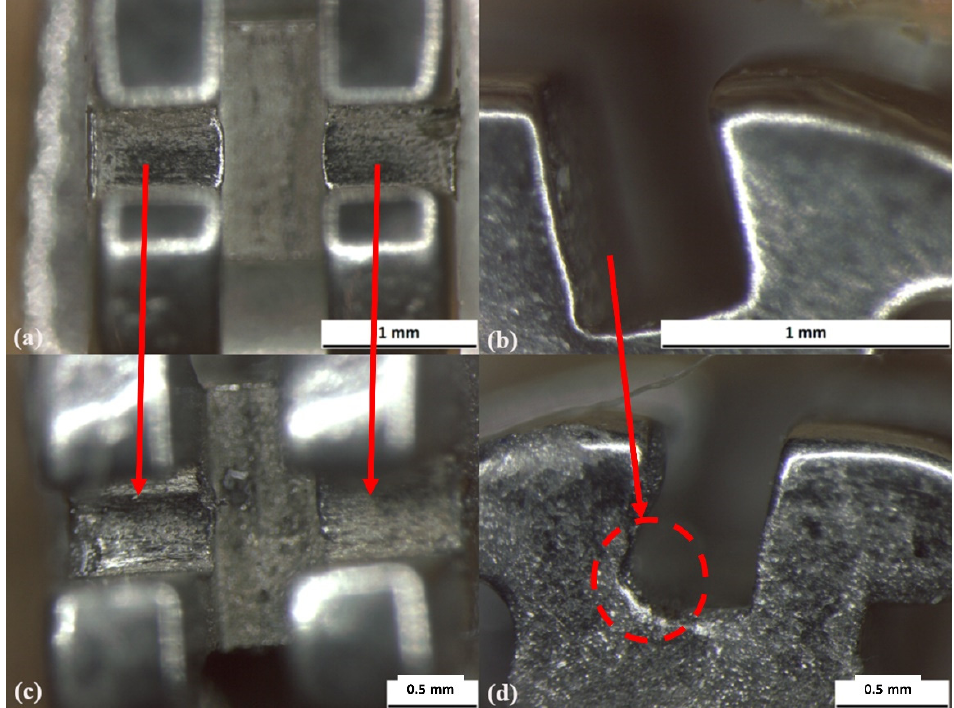
Figure 11. CB1 bracket (Manufacturer 1) in top and side view: ( a , b ) before the test; ( c , d ) after the test. Table 10. XRF results of conventional brackets. Percentage by weight.